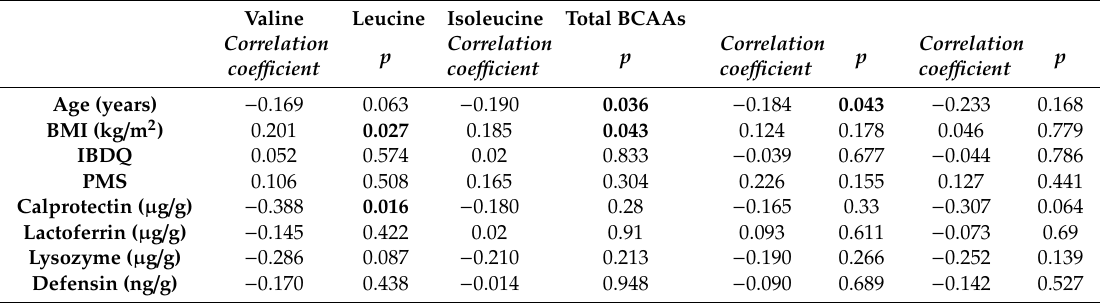
Table 3. Correlation of plasma BCAAs with clinical indices, stool inflammatory biomarkers and age of patients with UC.